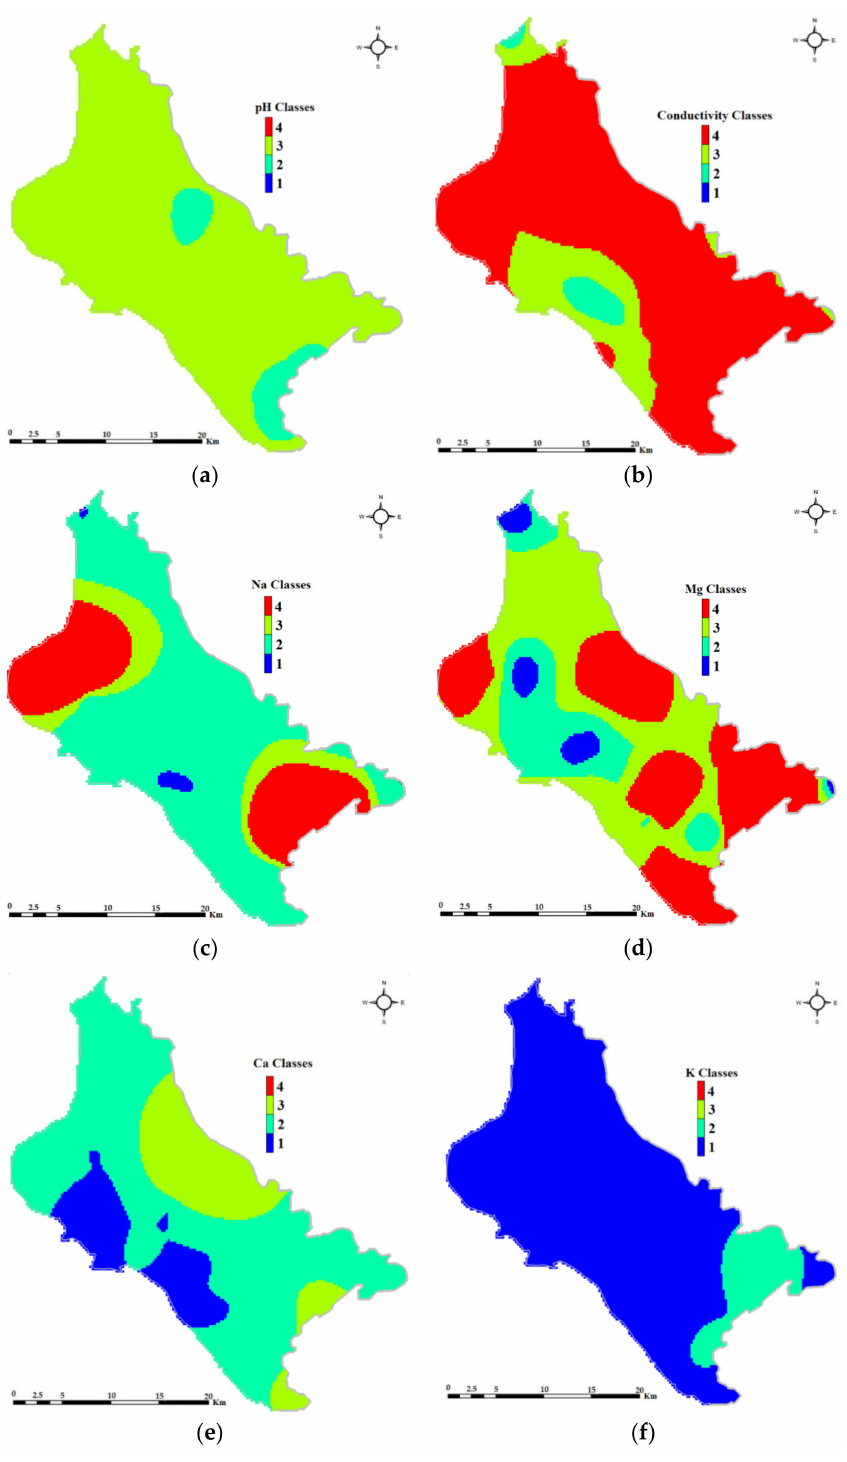
Figure 7. Maps of aquifer indicating the spatially distributed classes of: ( a ) pH, ( b ) conductivity, ( c ) Na, ( d ) Mg, ( e ) Ca, ( f ) K. Table 4 summarizes the methodologies, analysis results and the classes which are used for the assessment of desertification risk